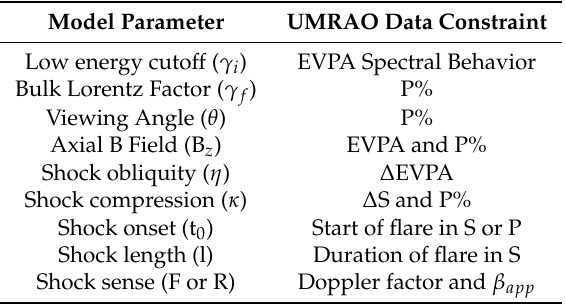
Table 1. Free Parameters of the Jet and Shock System and the Constraining